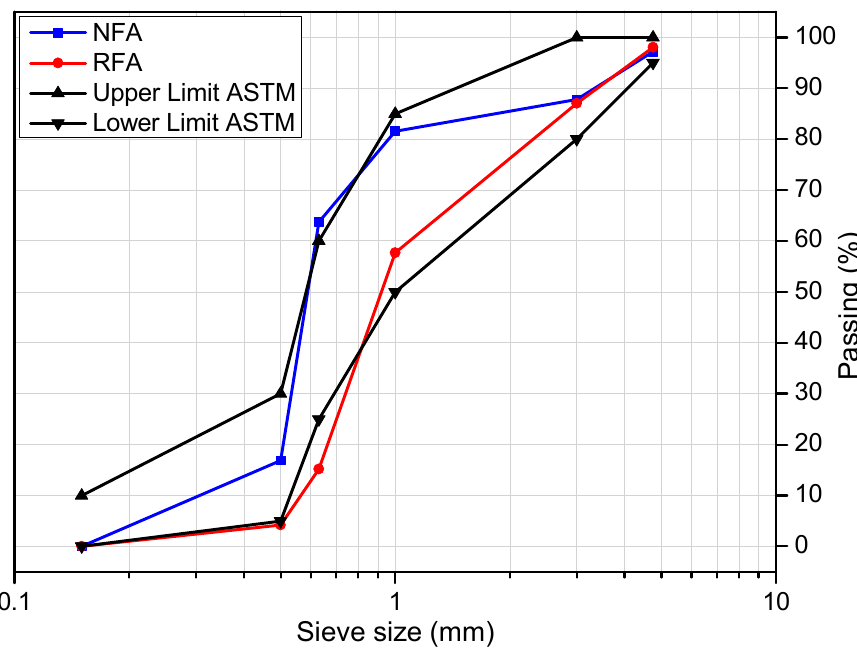
Figure 3. Particle size distribution of fine aggregates.